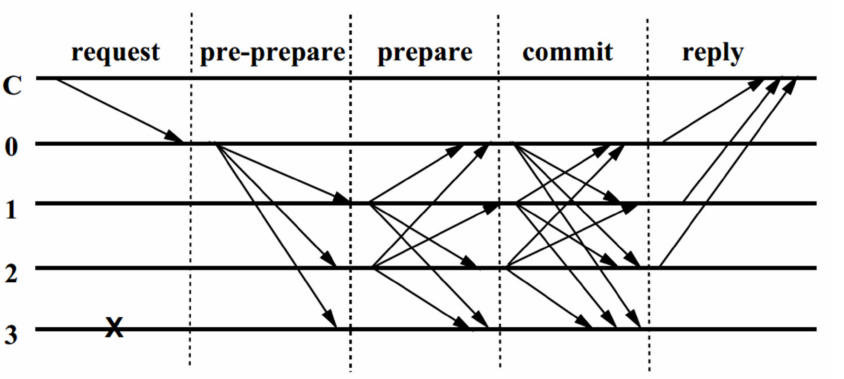
Figure 7. PBFT consensus algorithm broadcast process.